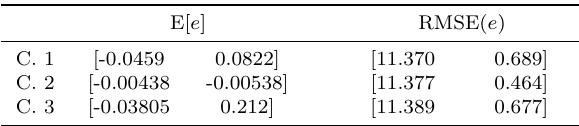
Table 7: Case 1–3, mean-of-error and RMSE values for